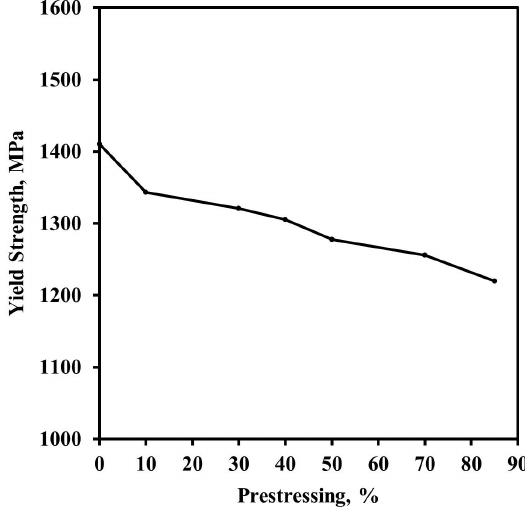
Figure 6. The decrease in the yield strength of the plasma-hydrogenated prestressing steel wire samples to various